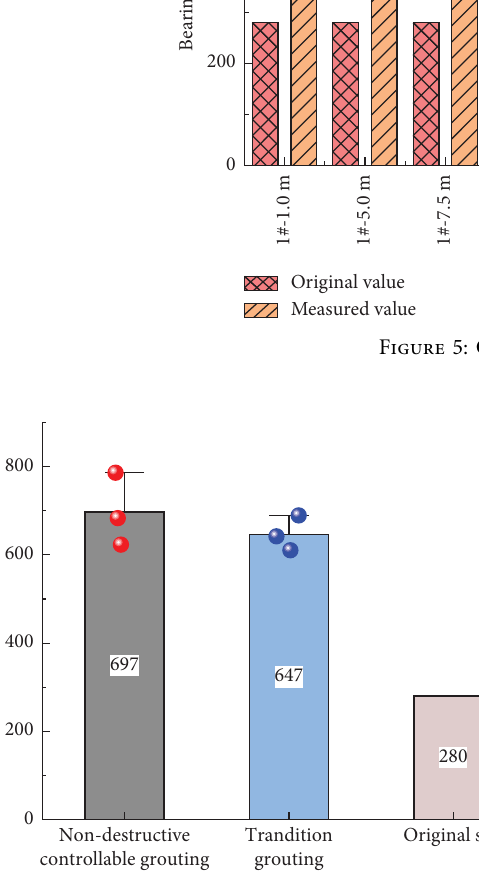
Figure 6: Bearing capacity of building by diference grouting